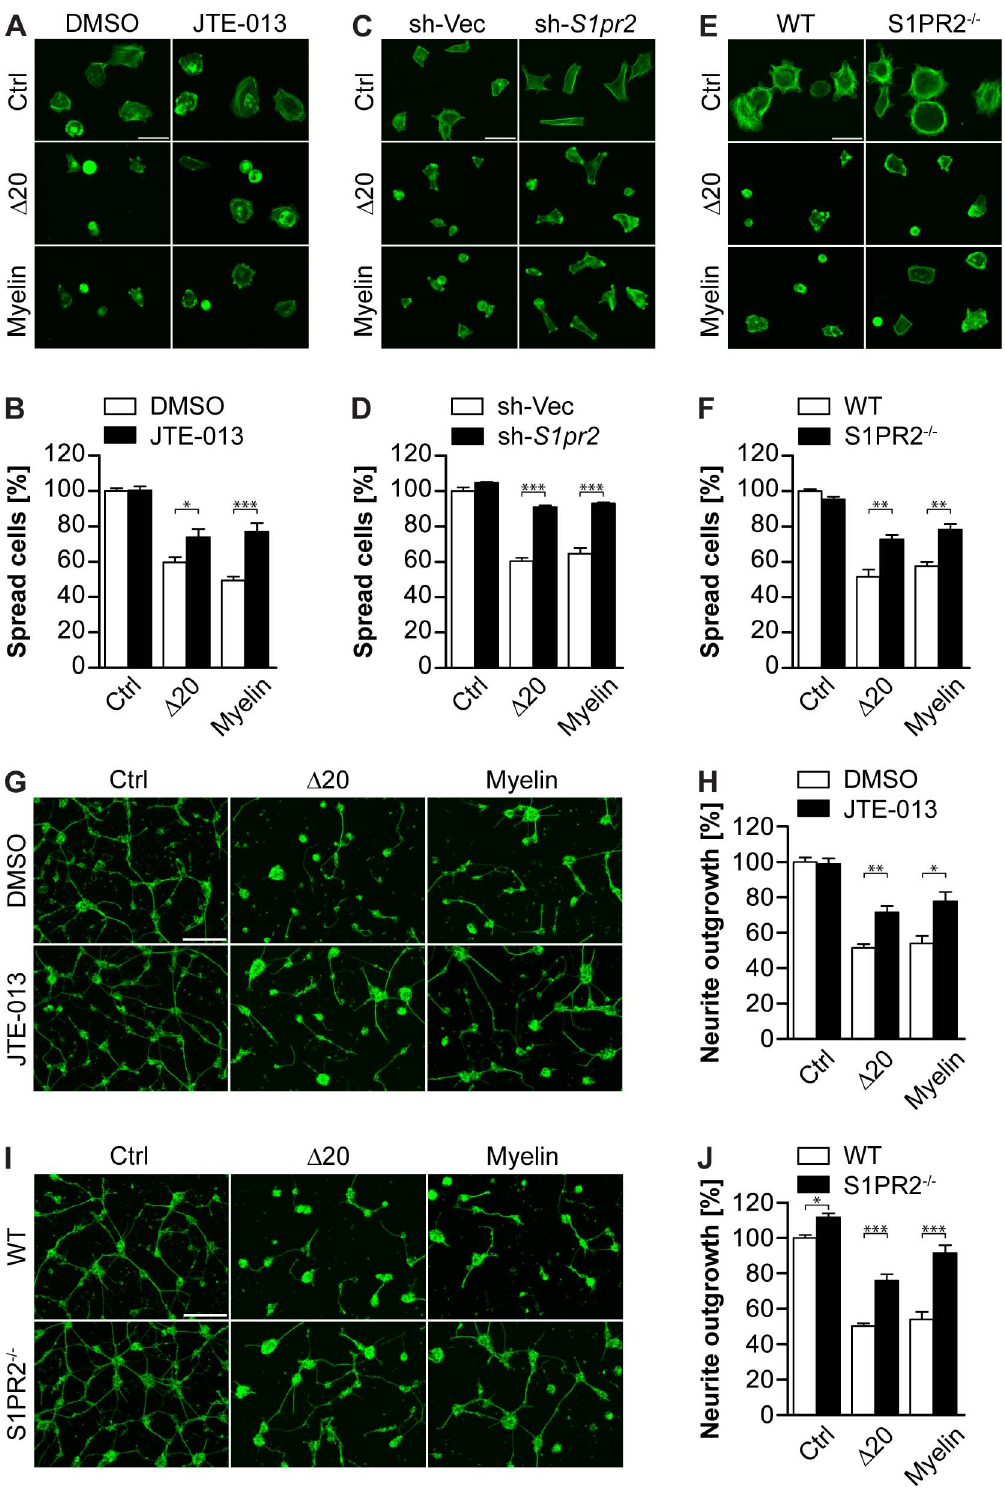
Figure 4. S1PR2 mediates Nogo-A- D 20- and myelin-induced inhibition of cell spreading and neurite outgrowth. (A,C) Representative pictures of 3T3 fibroblasts treated with JTE-013 or vehicle (DMSO) (A), or stably carrying a S1pr2 shRNA (sh- S1pr2 ) or empty vector (sh-Vec) construct (C) and plated on control, Nogo-A- D 20 or myelin substrates. (B,D) Cell spreading quantification of (A) and (C). (E) Representative pictures of MEFs isolated from WT or S1PR2 2 / 2 mice and plated on control, Nogo-A- D 20, or myelin substrates. (F) Cell spreading quantification of (E). Cells were stained with Alexa488-conjugated Phalloidin in (A, C, and E). (G,I) Representative pictures of P5–8 cerebellar granule neurons treated with JTE-013 or DMSO (G), or isolated from S1PR2 2 / 2 or WT mice (I) and plated on PLL (ctrl), Nogo-A- D 20 or myelin substrates. (H,J) Normalized mean neurite length per cell quantification of (G) and (I). Neurons were stained with b III-Tubulin in (G) and (I). Data shown are means 6 SEM ( n =3–6 experiments; * p , 0.05, ** p , 0.01, *** p , 0.001). Scale bars: 50 m M. doi:10.1371/journal.pbio.1001763.g004 PLOS Biology |